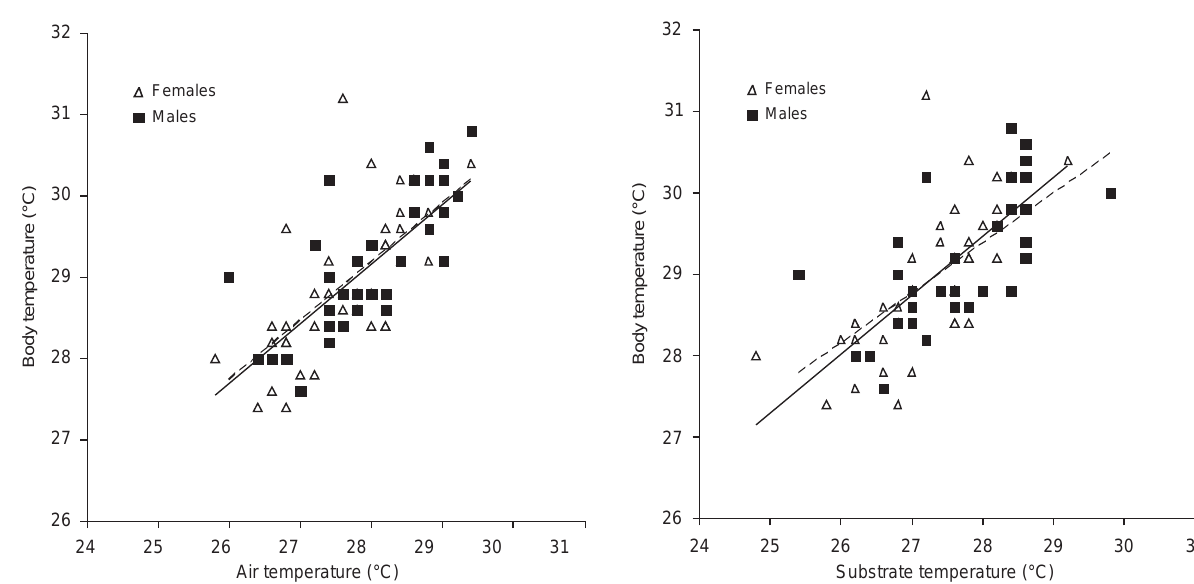
Figures 1-2. Relationships between air and body temperatures (1) and between substrate and body temperatures (2) of G. humeralis males and females. The dashed line represents the regression line for males (air vs. body, y = 0.73 x + 8.86, R 2 = 0.56, p <